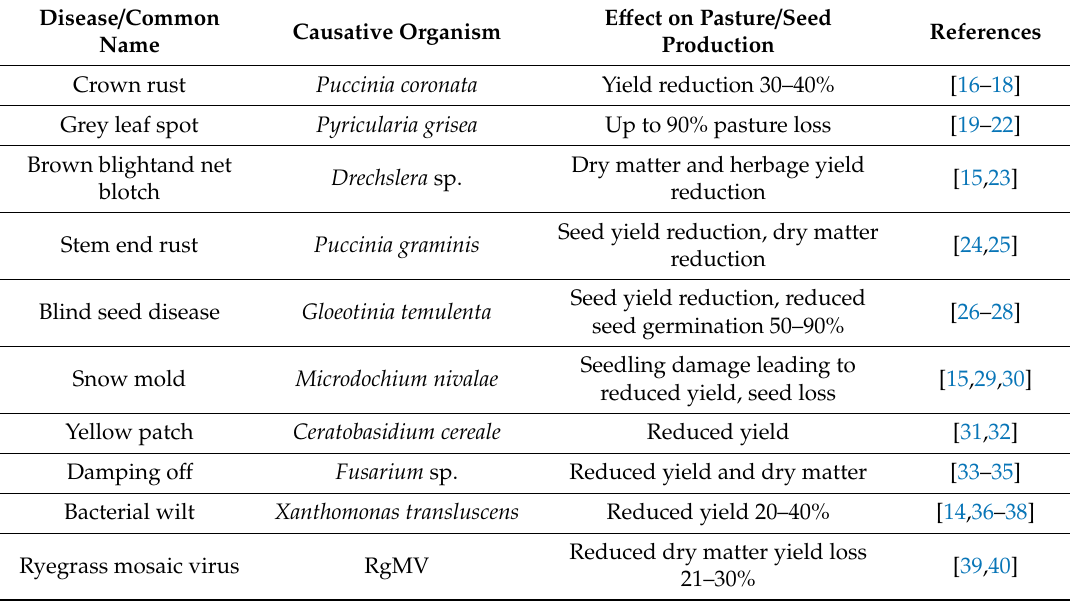
Table 2. Disease threat to perennial ryegrass, their causative agents and observed production